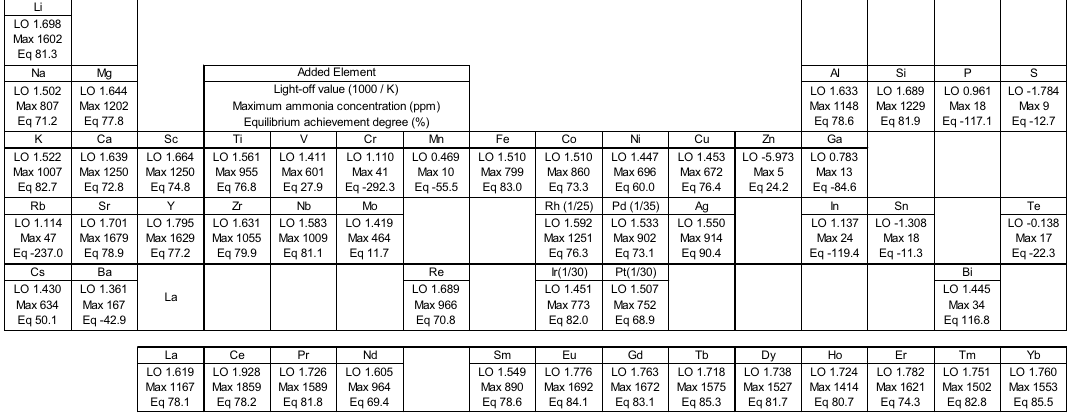
Figure 3. Light-off values (1000/K), equilibrium achievement degrees (%), and maximum ammonia concentrations (ppm) for the catalysts in this study according to the added element.